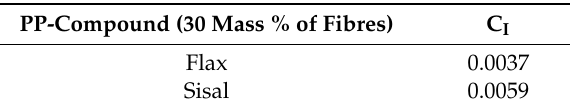
Table 2. Fibre interaction coefficients C I for flax and sisal